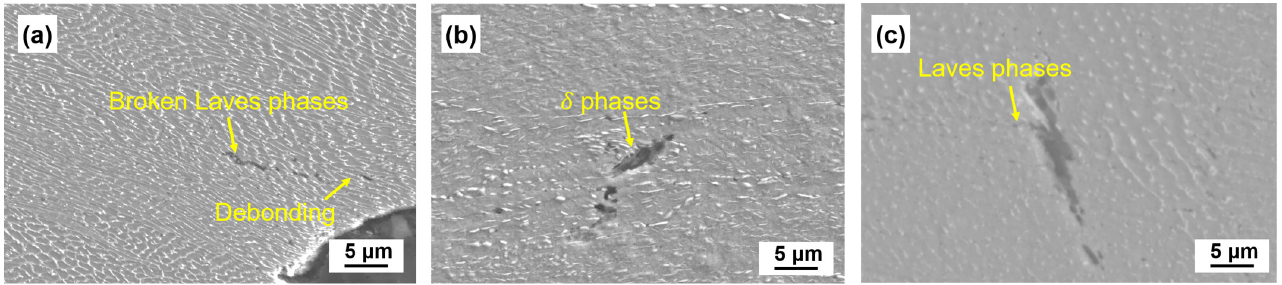
Figure 11. The SEM photographs of the longitudinal sections of the fractures: ( a ) AB; ( b ) SS; ( c )